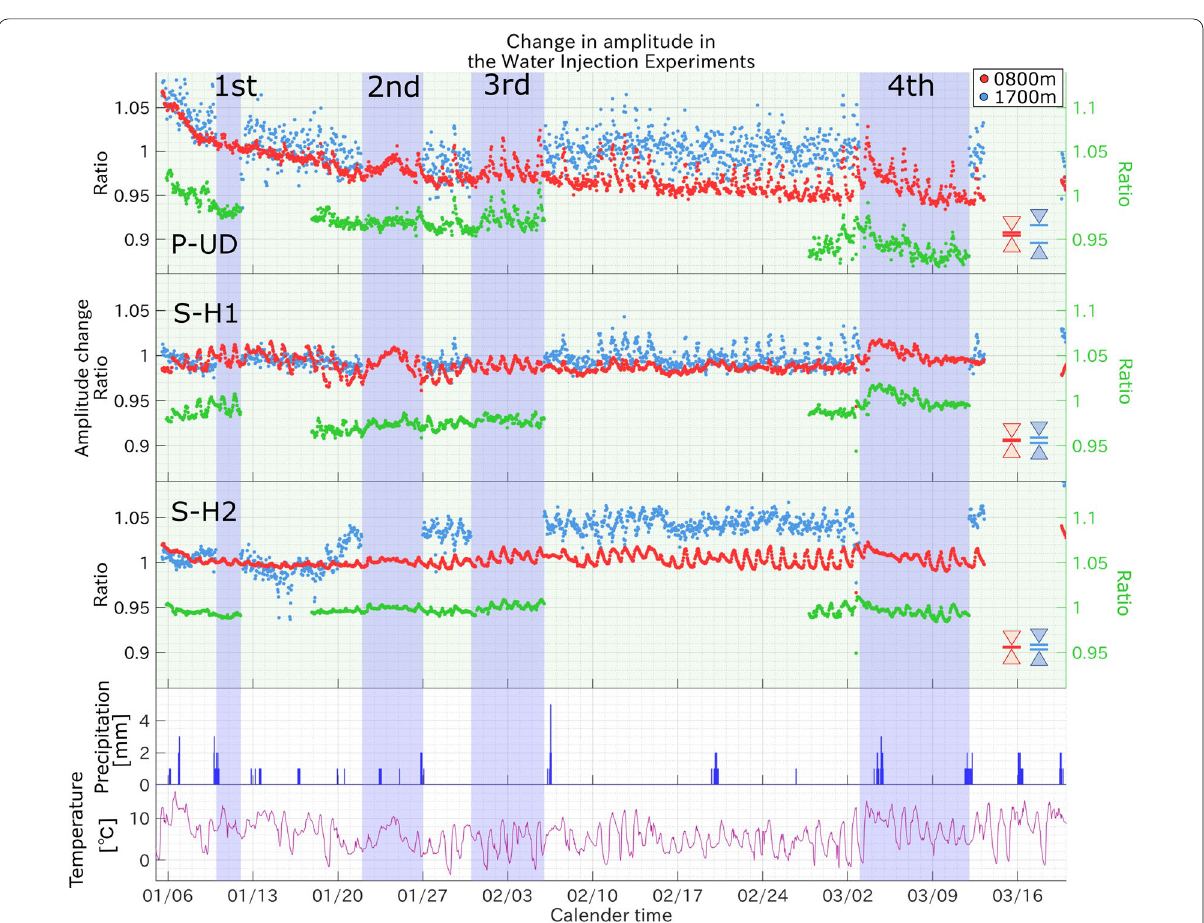
Fig. 8 Change in amplitude during the period around the water injection experiments. The bottom row shows the temperature observed at the Gunka station. The blue background indicates the periods of the injection experiments. Red and Blue dots show the variation in amplitude for the 800-m and 1700-m sensors, respectively. Green dots show the variation in amplitude at the 800-m sensors after the reduction of the effects of atmospheric temperature. We make a vertical offset of 0.05 for this plot. The values of green dots are shown in the vertical axis in right side of the graphs. During the water injection experiment, the transfer function of the 1700-m sensor could not be analyzed because of the noise caused by the injection. The gap between horizontal lines with a pair of triangles on the right side of the panels show the mean error of the amplitude